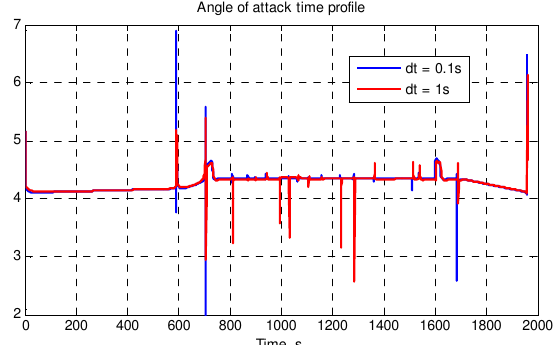
Fig 18. Time profiles of guidance system’s requested angle of attack for integration with two different time steps